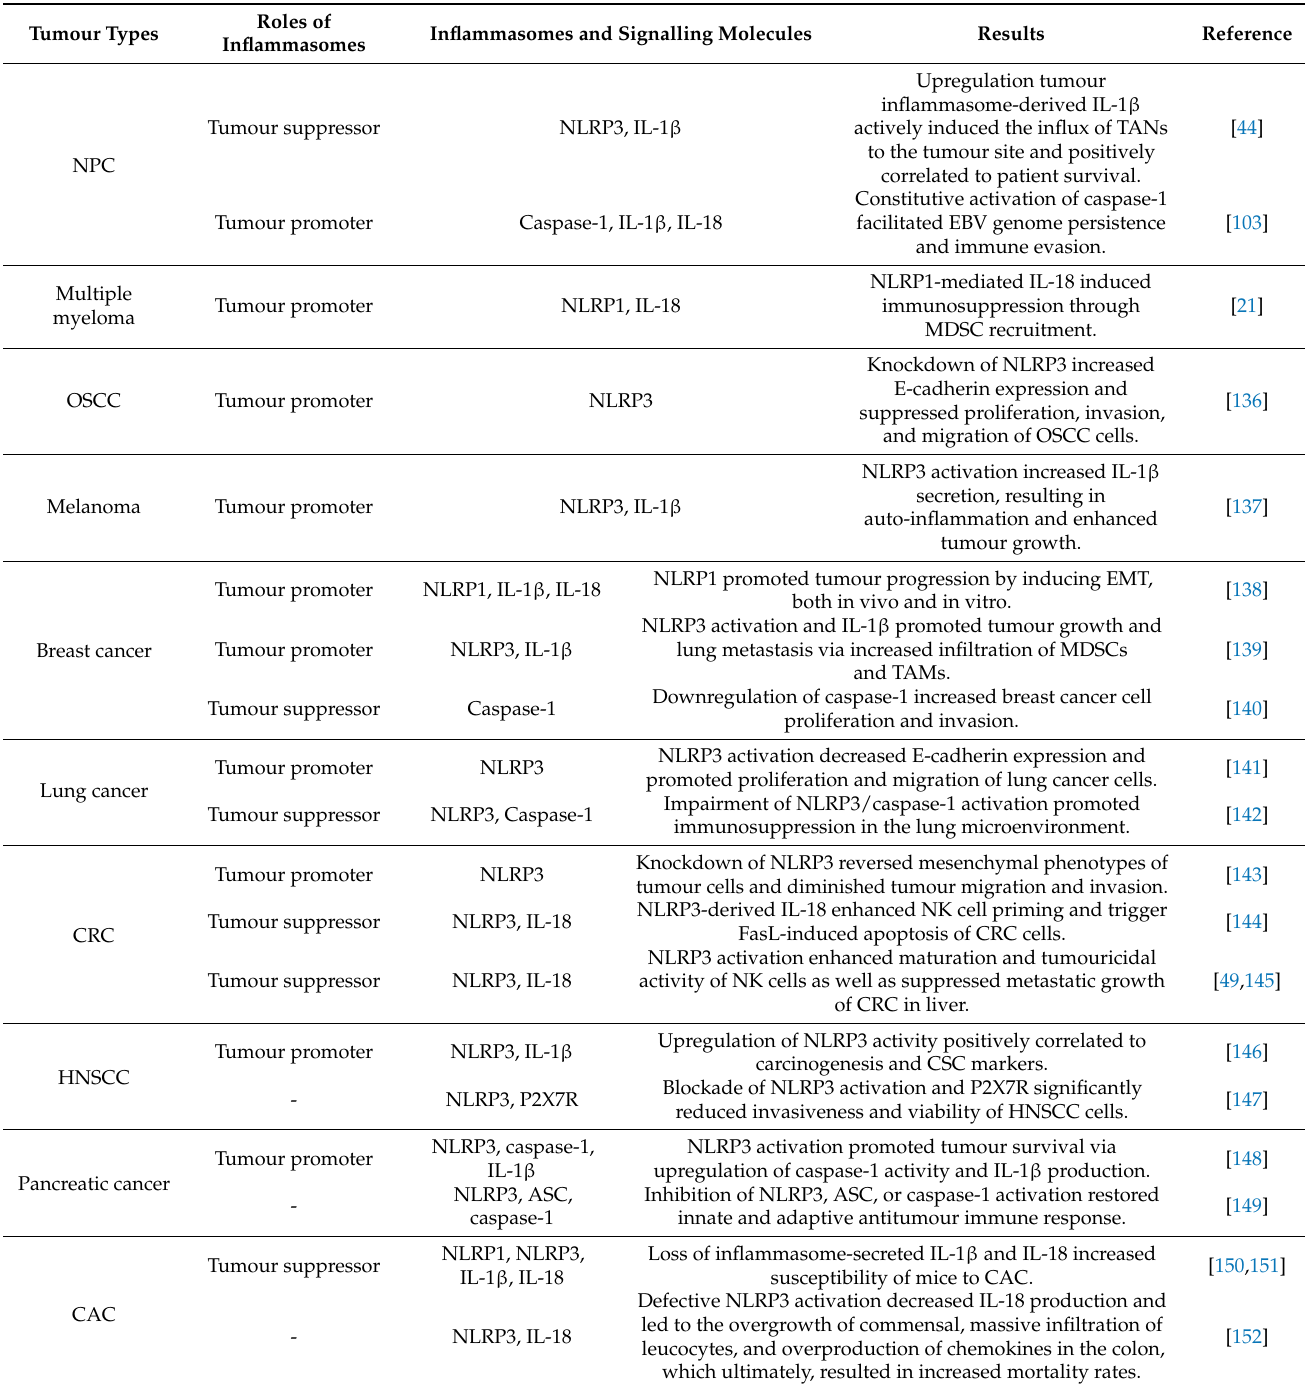
Table 1. The contrasting roles of inflammasomes in